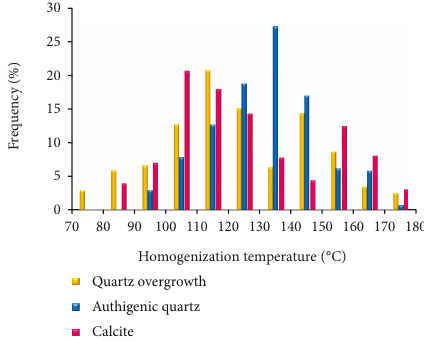
Figure 12: Histograms of homogenization temperature ( T fl uid inclusion in quartz overgrowth, authigenic quartz, and calcite in the He 8, Shan 1, and Shan 2 sandstone samples (modi fi ed after [15,